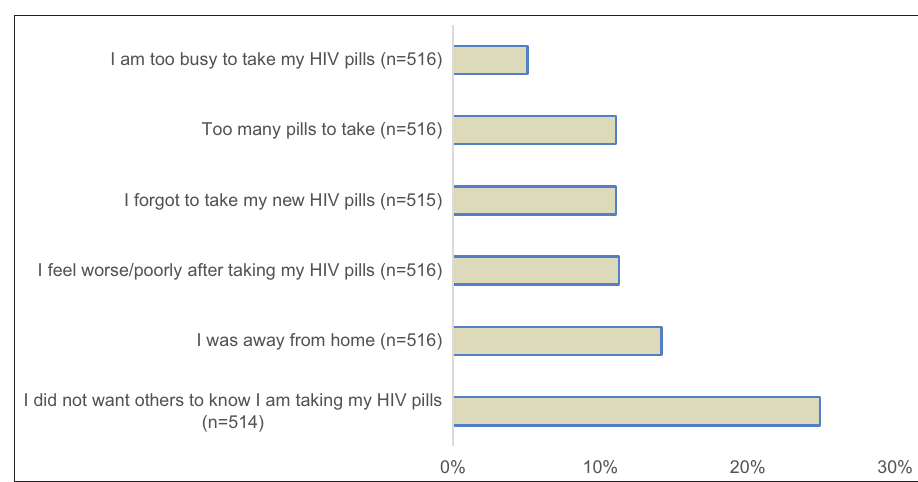
Figure 2: Reasons for non-adherence to antiretroviral therapy among pregnant women, Niger state, northcentral